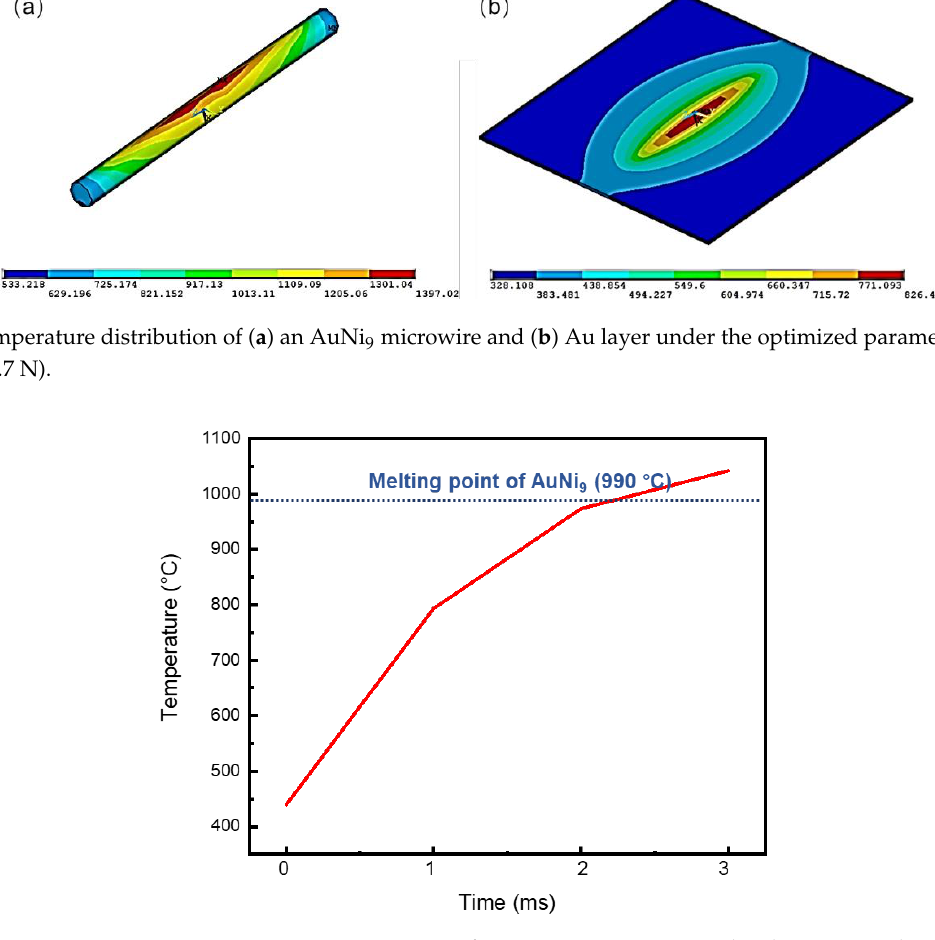
Figure 10. Temperature curve of an AuNi 9 microwire under the optimized parameters (0.275 kA, 3 ms, and 28.7 N).